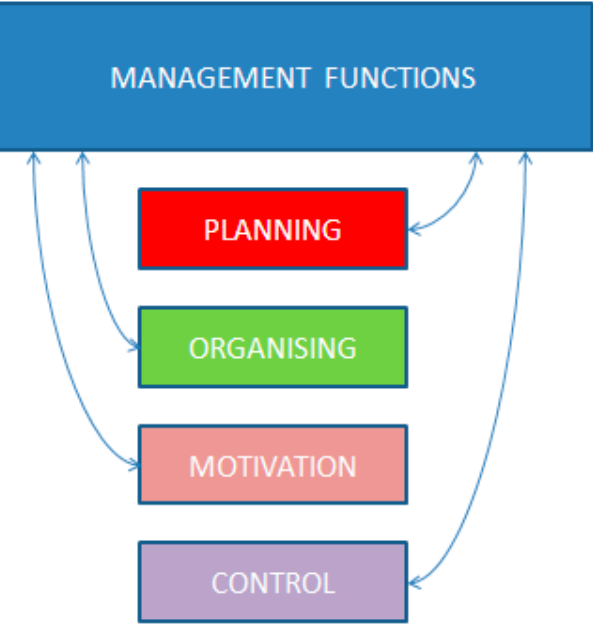
Figure 1. Basic management functions.